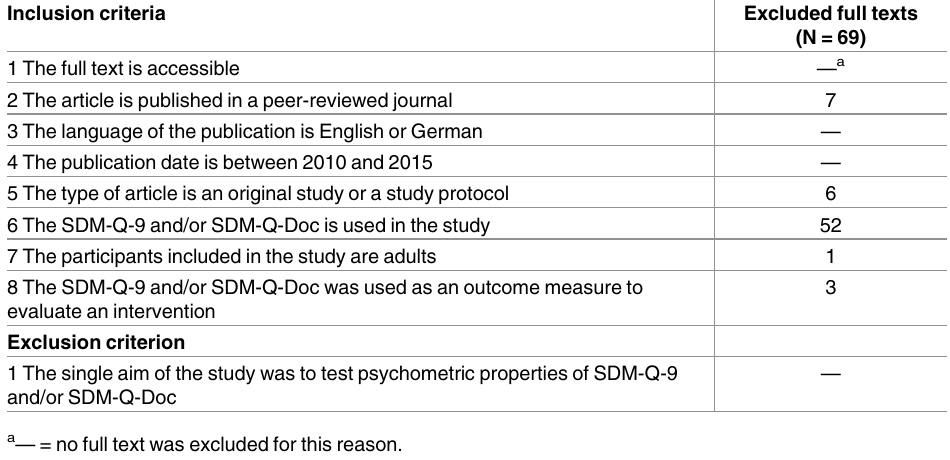
Table 1. Inclusion and exclusion